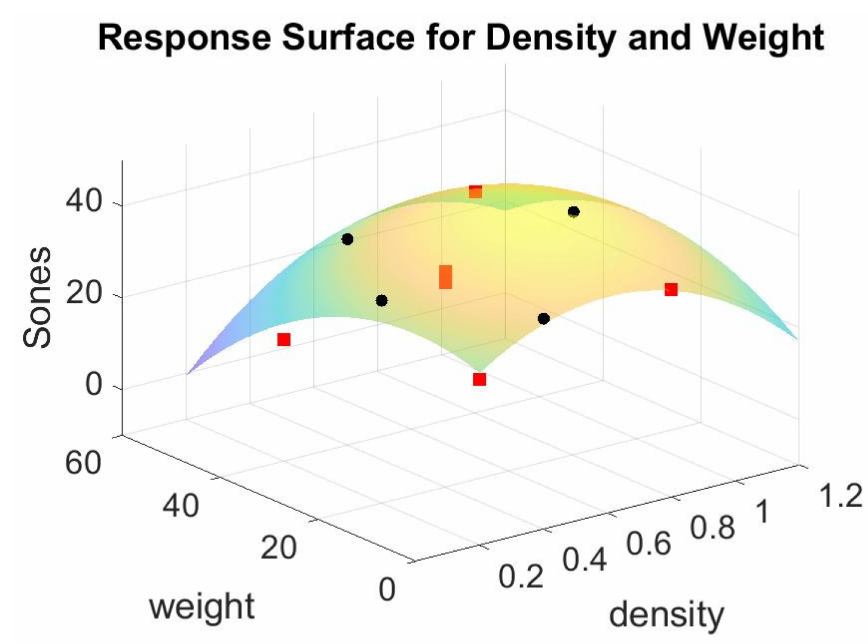
Figure 11. The response surface for ten data points in Table 4 in bigger range. Table 5. The ANOVA of data in Table 4. Analysis of